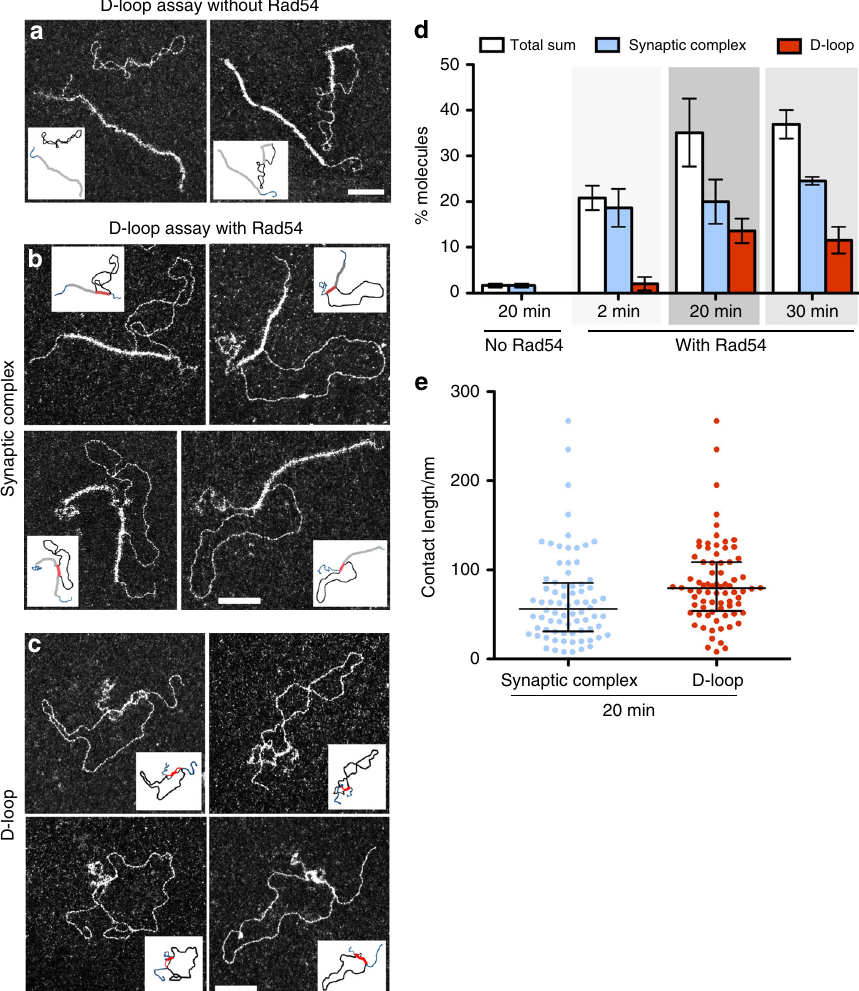
Fig. 2 Rad54 promotes the formation of synaptic complexes and D-loops as visualized by EM of DNA-protein complexes. a – c Representative EM pictures of a reactions without Rad54, b Rad51-mediated synaptic complexes and D-loops c from reaction containing Rad54. In all EM pictures, white bars represent 100 nm. For additional images see Supplementary Fig. 1b, c. d Quanti fi cation of synaptic complexes and D-loops in DNA-protein samples. Error bars in d indicate standard deviation from three independent experiments. The percentage of molecules was determined by the ratio between the population of synaptic complexes or D-loops and the sum of these two categories of molecules plus free 5´ DNA junctions. ( n = 500 molecules for each experiment). Note that this division into two categories was performed by EM visual analysis therefore rare subjective analysis-associated errors cannot be rolled out. e Contact length for synaptic complexes and deproteinized D-loops at 20 min, showing median with interquartile range. Source data are provided as a Source Data fi